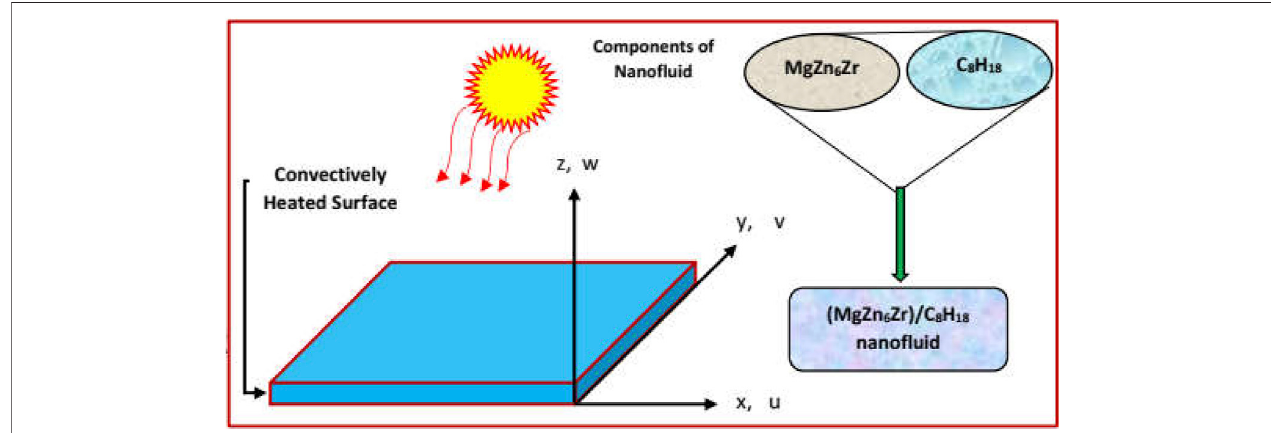
FIGURE 2 | Flow region of (MgZn 6 Zr)/C 8 H 18 .